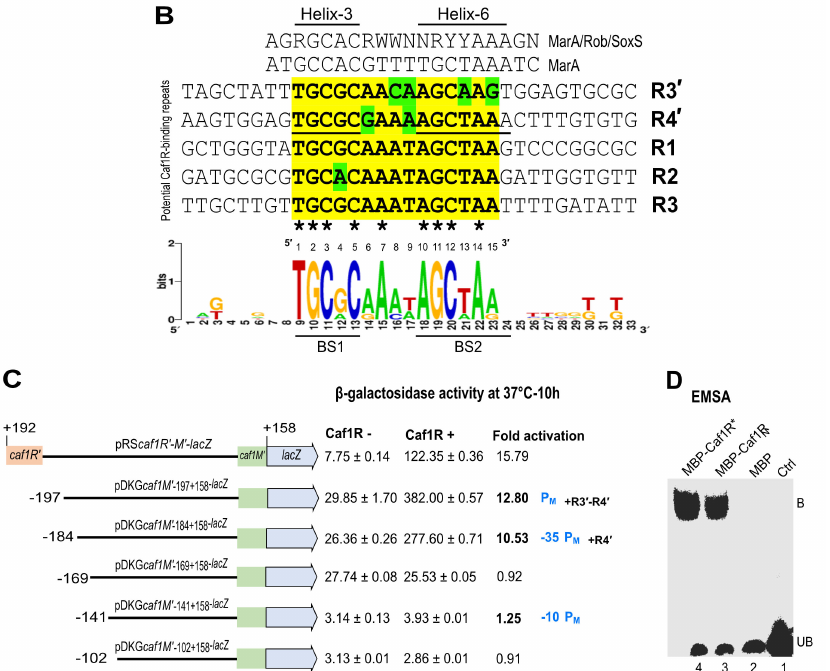
Figure 5. Caf1R facilitates transcription activation of the caf locus. ( A ) Organisation of genes of the caf locus [5.128 kb]. Genes are drawn as per their size and location; orientation of transcription is indicated, caf1R (black arrow) and cafMA1 (blue arrow). Sequence encompassing caf1R-cafMA1 intergenic region illustrates regulatory features. The caf1R and cafMA1 Shine-Dalgarno (SD) motifs are as predicted [18,61,62]. For clarity, σ 70 bacterial promoter elements (-10 and -35) only for the cafMA1 operon are indicated. Caf1R-dependent promoter, P M regulating cafMA1 operon is confirmed in this study. P M consensus elements (bold capital nt) and non-consensus (small nt) are underlined. Previously predicted promoter elements (-10_1 & -35_1 and -10_2 & -35_2) for caf1M [18] and BPROM predicted promoter elements, -10_3 & -35_3 are underlined. Identified repeats are labelled as R1-R3, predicted caf1R autoregulation (red arrows) and R3 (cid:48) and R4 (cid:48) for cafMA1 (black arrows), small nt- variants. ( B ) Alignment of the identified repeats with conserved (yellow) and variant nt (green). Absolutely conserved nt among these repeats are indicated as *. The consensus motif for the MarA/Rob/SoxS A/X family [22] is- R: A/G, Y: C/T, W: A/T and N: A/T/G/C. The predicted binding sites of R4 (cid:48) sequence interacting with proposed helix-3 (BS1) and helix-6 (BS2) of the Caf1R is bold underlined (identified based on mar -MarA co-crystal structure [25]. ( C ) Schematic of the caf1R-caf1M transcriptional lacZ fusions. The largest construct has the entire intergenic regions plus +192 and +158 flanking sequence from caf1R and caf1M , respectively. Location of truncations within the intergenic region are numbered with respect to ATG of caf1M and are indicated by a blue arrow in ( A ). The β -galactosidase activity of the fusions, with and without plasmid complementation of Caf1R and fold activation in presence of Caf1R is indicated. Standard error of mean ( ± SEM) is from three biological replicates. ( D ) EMSA, in-vitro binding of MBP-Caf1R*/R N to the oligonucleotide [47 bp] encompassing R4 (cid:48) (blue underlined sequence in ( A ). MBP-Caf1R*, MBP-Caf1R N and MBP, cell lysates from E. coli K12 2508 expressing the relevant recombinant protein. Ctrl- reaction